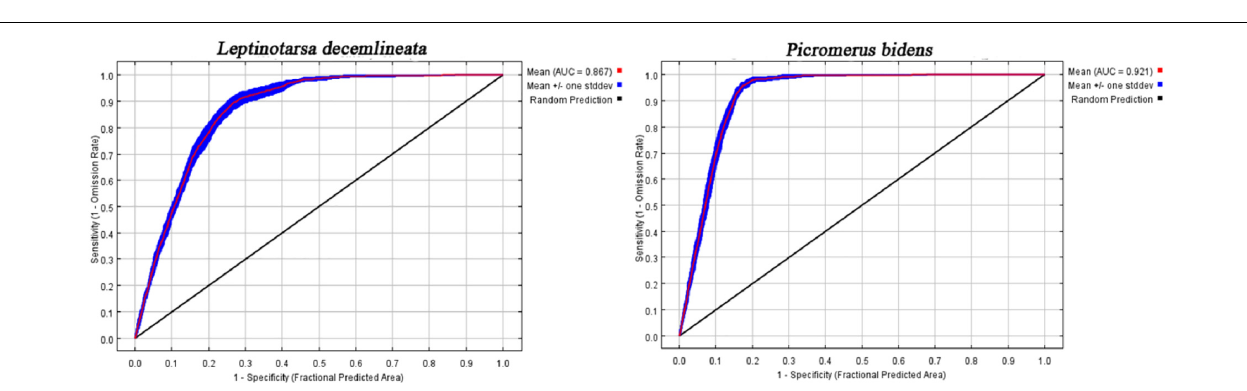
FIGURE 3 | The AUC curves in the developing CPB and P. bidens distribution